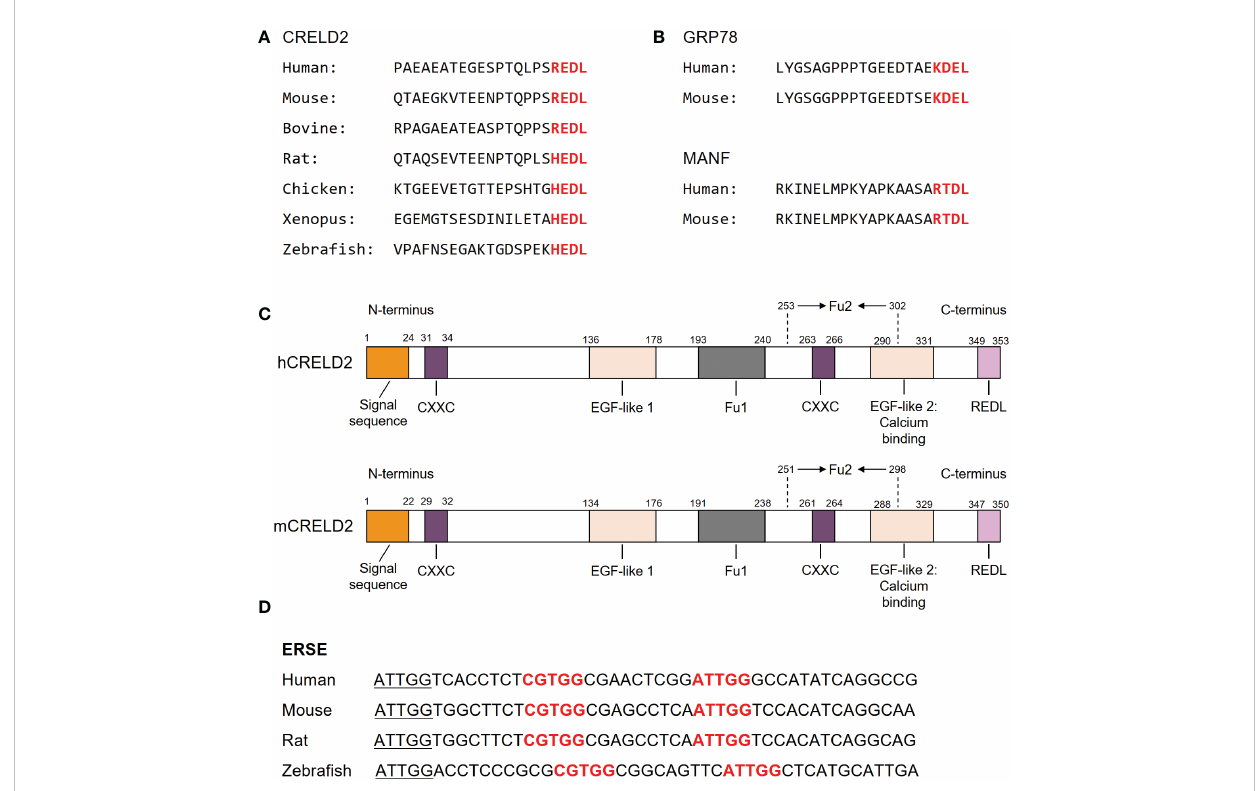
FIGURE 2 Molecular structure of CRELD2. (A) Comparison of amino acid sequences of CRELD2 at the C-terminus among various species. The conserved amino acids are shown in red font. (B) Four conserved C-terminal amino acids in GRP78 and mesencephalic astrocyte-derived neurotrophic factor (MANF) among species including human and mouse. The conserved amino acids are shown in red font. (C) Schematic of human and mouse CRELD2 protein. (D) Comparison of ERSE nucleotide sequences among various species. Conserved ERSE is shown in red